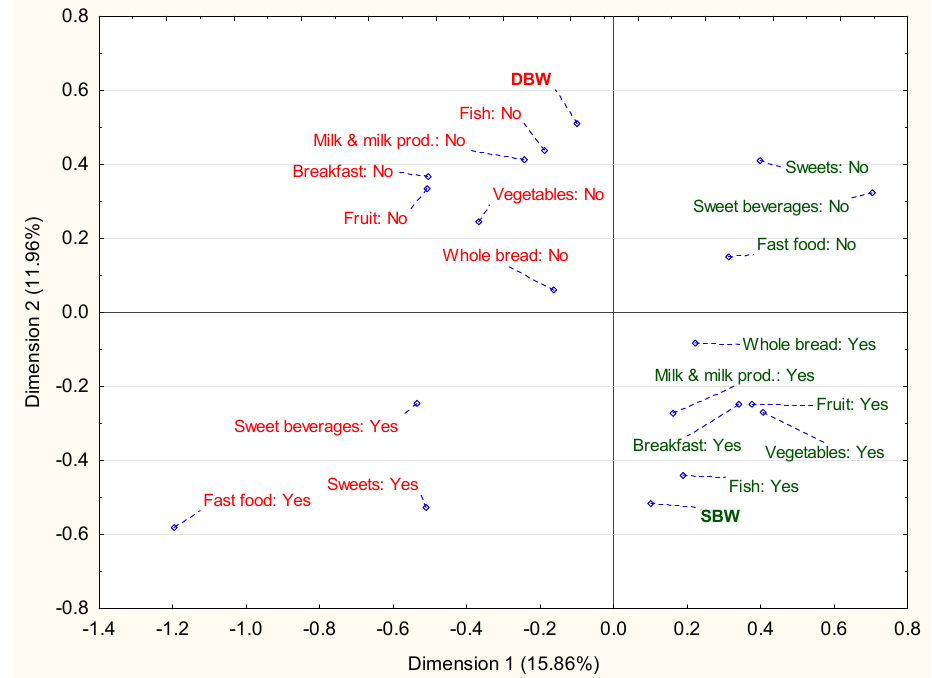
Figure 1. The results of the analysis of correspondence of eating behaviors in SBW (satisfied with body weight—green) or DBW (dissatisfied with body weight—red) groups ( n = 14,044).